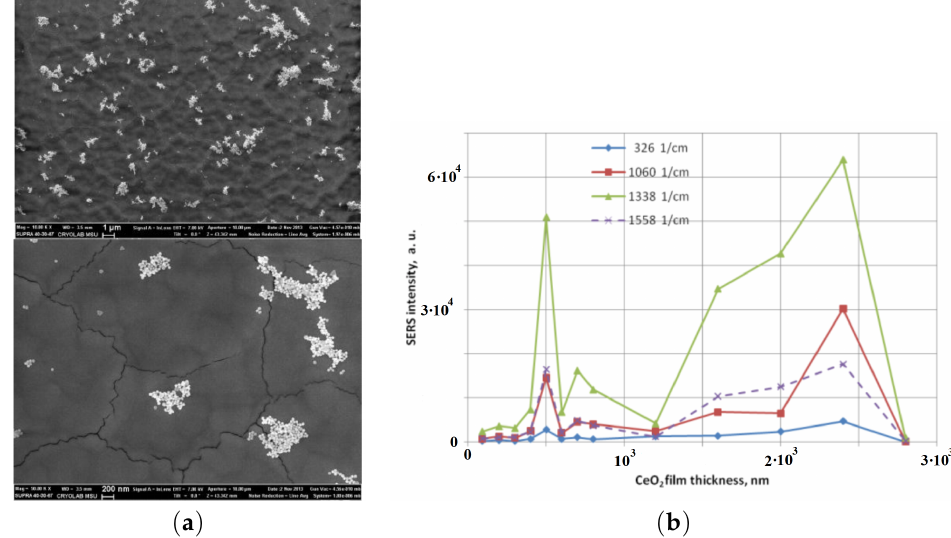
Figure 10. ( a ) SEM images of facet CeO 2 films with gold nanoparticles (AuNP); scale bars are 1 µ m and 200nm for the top and bottom images, respectively; ( b ) SERS intensity for four Raman shifts from conjugate of DTNB/AuNP on CeO 2 films as function of the film thickness (after normalization that is the Raman signal is divided into the number of AuNP in the spot, where the signal is collected